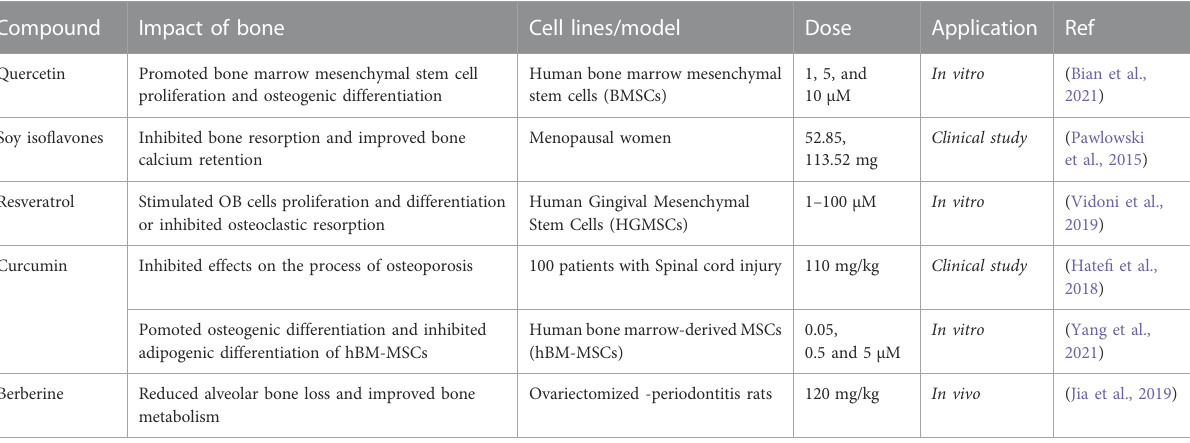
TABLE 5 Phytochemicals and bone